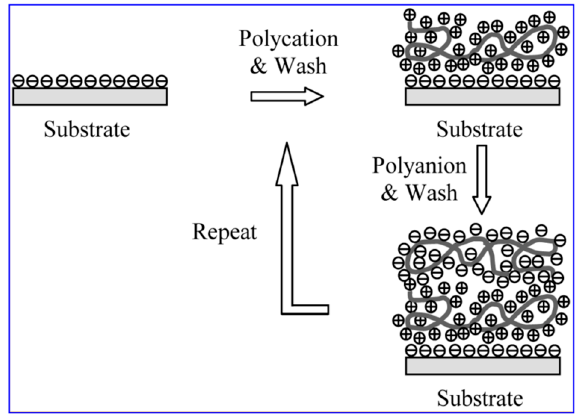
Figure 1. Assembly of the ionic self-assembled multilayer (ISAM) film. Polycationic and polyanionic solutions were alternately deposited on the optical fiber to form the ISAM film.